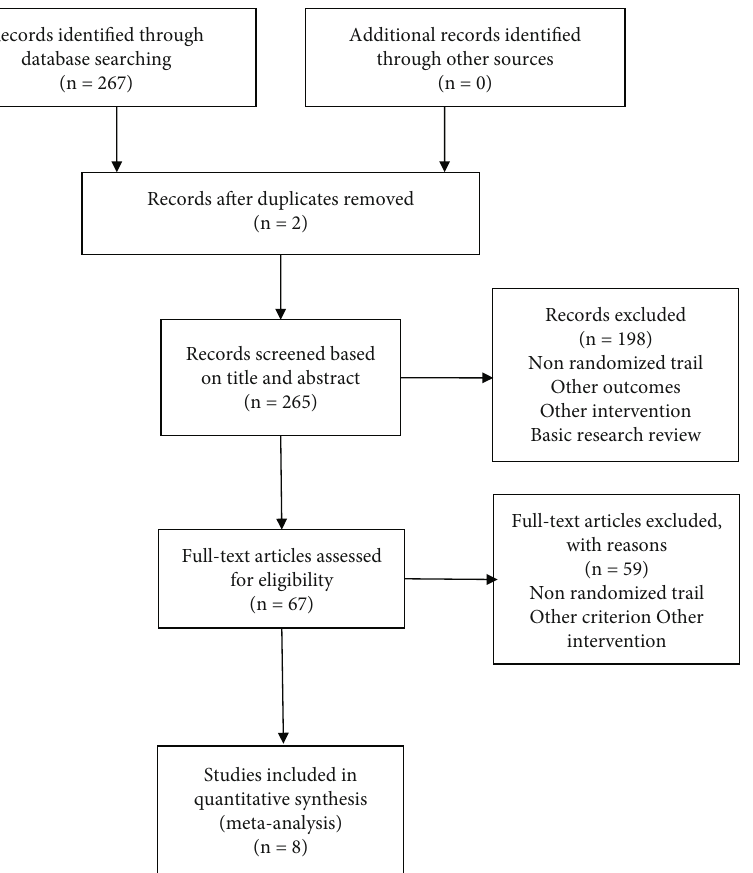
Figure 1: The fl ow chart of the literature selection process and the reasons for